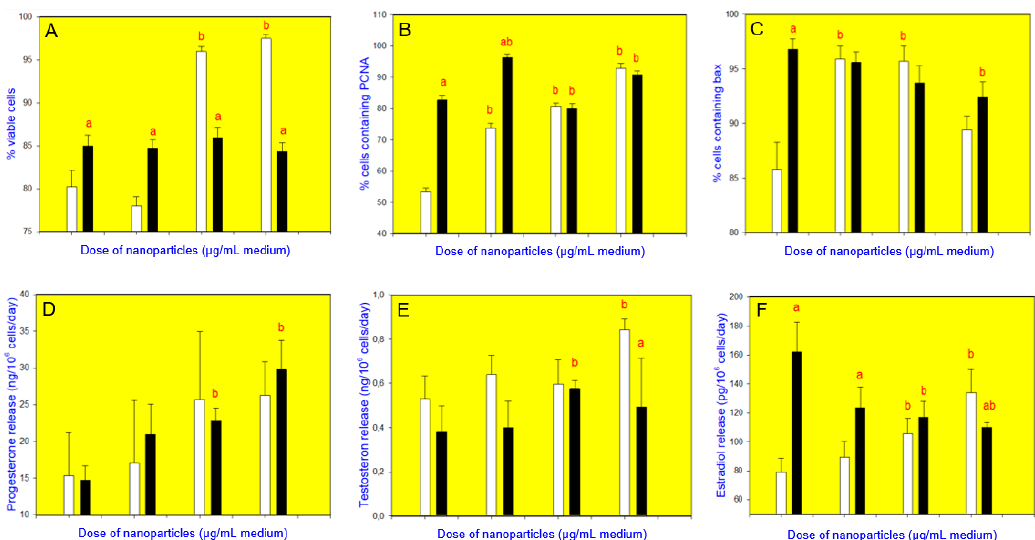
Figure 3. Effect of CuNPs/TiO 2 (0, 1, 10, or 100 µg/mL) alone (white bars) and in combination with buckwheat ( Fagopyrum esculentum , 10 µg/mL; black bars) on the viability (Trypan blue exclusion assays) ( A ), proliferation (expression of proliferating cell nuclear antigen, PCNA, quantitative immunocytochemistry) ( B ), apoptosis (expression of bax, quantitative immunocytochemistry) ( C ), and secretion of progesterone (enzyme-linked immunosorbent assay, ELISA) ( D ), testosterone (ELISA) ( E ), and 17 β -estradiol (ELISA) ( F ) in cultured porcine ovarian granulosa cells. The values are expressed as the mean ± SEM; a: effect of buckwheat-significant ( p < 0.05) differences between the corresponding groups of cells, treated and untreated with buckwheat and b: effect of CuNPs/TiO 2 -significant ( p < 0.05) differences between the cells, treated and untreated with CuNPs/TiO 2 .